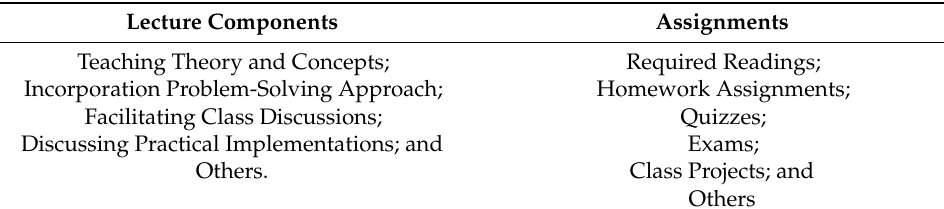
Table 4. Class components and assignments selected for analysis in the survey.